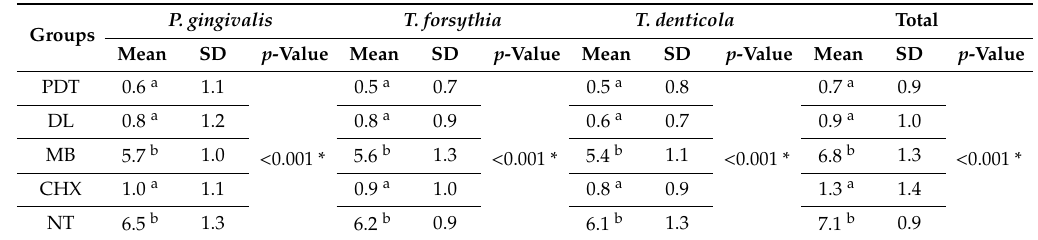
Table 1. Mean and standard deviation of periodontal bacteria assessed with total counts in logarithms. Groups